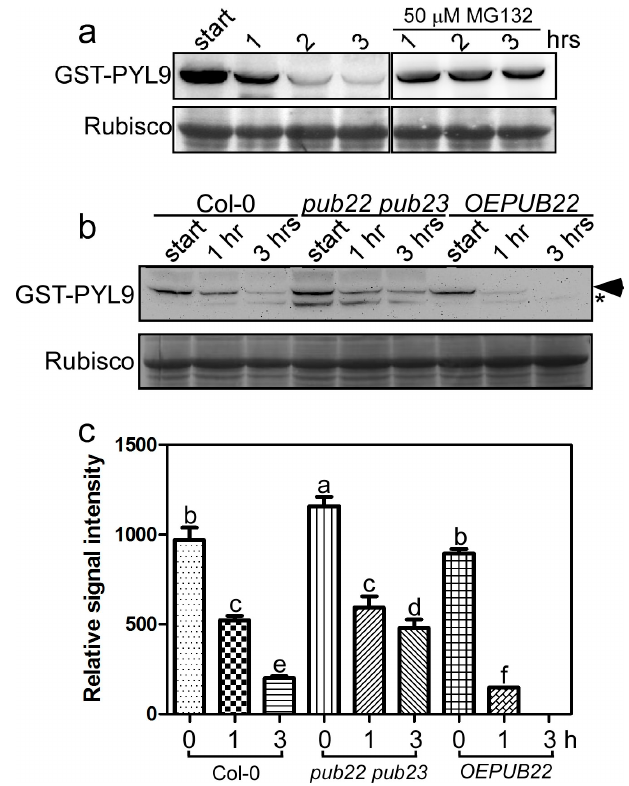
Figure 4. PUB22 and PUB23 regulate GST-PYL9 stability in cell-free degradation assay. ( a ) The degradation of GST-PYL9 in the extract from the wild-type at indicated time. MG132, a specific 26S proteasome inhibitor, was used as a proteasomal activity control. Coomassie brilliant blue (CBB) staining of Rubisco was used as loading control. ( b ) The degradation of GST-PYL9 in the wild-type, the pub22 pub23 double mutant and the transgenic plants overexpressing PUB22 ( OEPUB22 ). The total protein isolated from ten-day-old seedlings were incubated with GST-PYL9 for the indicated hours. GST-PYL9 was detected with anti-GST antibody. CBB staining of Rubisco was used as loading control. Asterisk may represent truncated GST-PYL9 or unspecific band. ( c ) Quantitative evaluation of the GST-PYL9 protein level in ( b ). Independent experiments were repeated three times with the similar results. Data are the means ± standard errors ( n = 3). Statistical significance was determined by a Student’s t -test; significant differences ( p ≤ 0.05) are indicated by different lowercase letters.